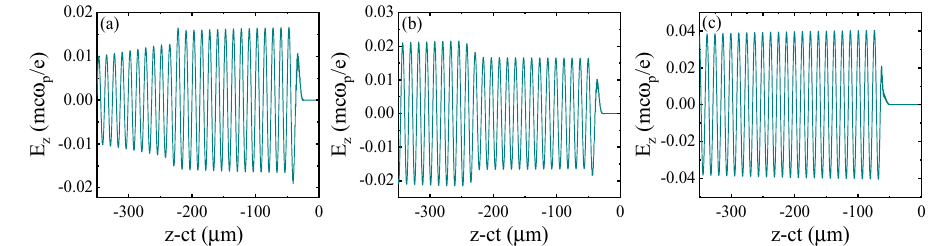
Figure 3. Snapshots illustrating the on-axis longitudinal wakefield, E z , generated by a 30 fs laser pulse at three axial distances of ( a ) 1.4 mm, ( b ) 2.2 mm, and ( c ) 1.2 cm, corresponding to propagation times of 4.6 ps, 7 ps, and 40 ps, respectively. The wakefield is normalized to the wave-breaking field E WB = m e ω p0 c / e , which is close